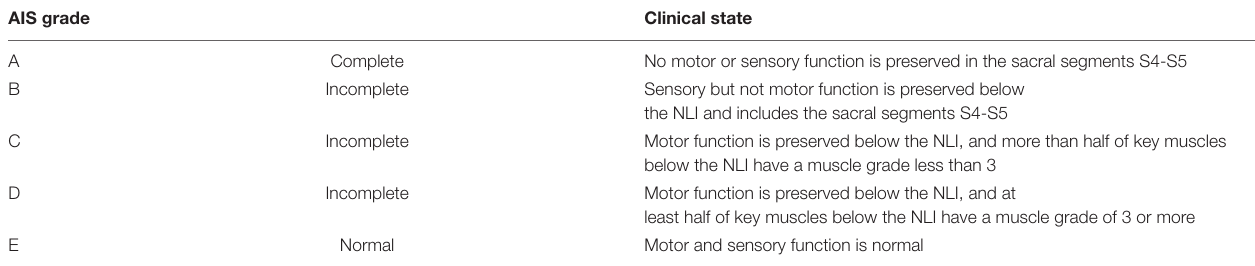
TABLE 3 | The American Spinal Injury Association Impairment Scale (AIS). AIS grade Clinical